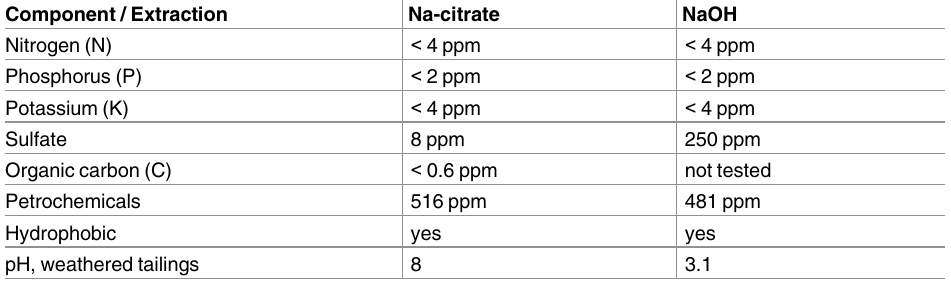
Table 1. Chemical characteristics of coarse tailing sand, extracted by two